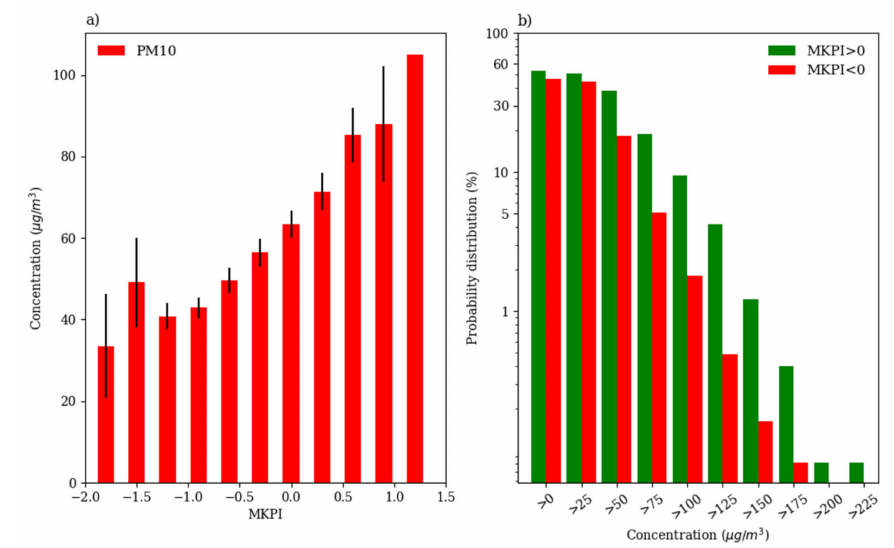
Figure 5. Distribution of percentages of PM 10 concentration in the winter for a given MKPI threshold value range ( a ), and MKPI > 0 and MKPI < 0 for a given PM 10 concentration threshold value range ( b ) for the 2001–2014 period. Error bars indicate significance at the 95% confidence